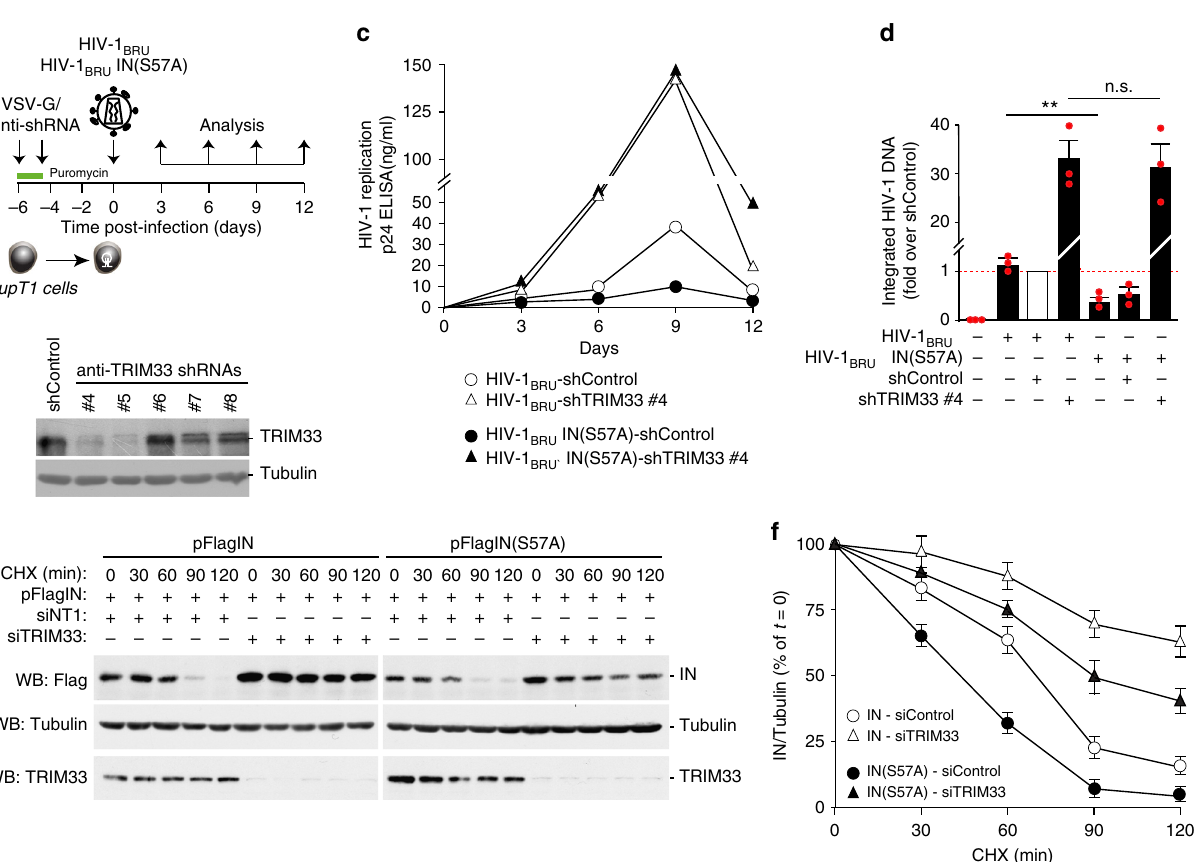
Fig. 6 TRIM33 inhibits HIV-1 infection. a Analysis of the effect of stable knockdown of TRIM33 in multiple round infection with wild-type HIV-1. SupT1 cells were fi rst transduced with lentiviral vector expressing different anti-TRIM33 shRNAs; after selection with puromycin, cells were infected with wild-type HIV-1 BRU or HIV-1 BRU IN(S57A), followed by analysis of infection over time by p24 ELISA. b Western blotting analysis showing endogenous TRIM33 levels in SupT1 cells transduced with lentiviral vectors expressing the indicated shRNAs and selected with puromycin. Tubulin was used as a loading control. c . Stable knockdown of TRIM33 enhances wild type HIV-1 replication and rescues replication of the IN(S57A) mutant. The graph show the levels of p24 in control Sup1 cells or cells previously transduced with anti-TRIM33 shRNA #4, which ef fi ciently knocks down TRIM33 expression, after infection with the two viruses. The results shown are representative or four independent experiments. d Quanti fi cation of the levels of integrated HIV-1 DNA in SupT1 cells, expressing an shRNA control or shRNA #4 against TRIM33, and infected with wild-type HIV-1 BRU or HIV-1 BRU IN(S57A), at day 3 after infection. Data are mean ± SEM; n = 3 independent experiments; ** P < 0.01; n.s. not signi fi cant; one-way ANOVA. e Silencing of TRIM33 protects both wild-type IN and mutant IN(S57A) from degradation. Expression plasmids for the two IN proteins were transfected into HeLa cells in which TRIM33 was knocked down by RNAi; cells were then treated with cycloheximide 30 µ g/ml for the indicated time points prior to lysis. The panel shows a representative immunoblots using antibodies against IN, TRIM33 and tubulin as a loading control. f Quanti fi cation of IN levels in the presence of cycloheximide for the indicated time points in the whole cell extracts of SupT1 cells treated with siRNAs against TRIM33 or not targeting and transfected with either wt IN or IN(S57A). After normalization for Tubulin, data (mean ± SEM; n = 3 independent experiments) are expressed as a percentage of time = 0 for each